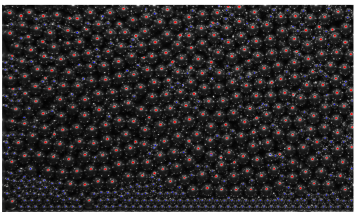
Figure 3. Detected particle: red (2mm) and blue (1mm)